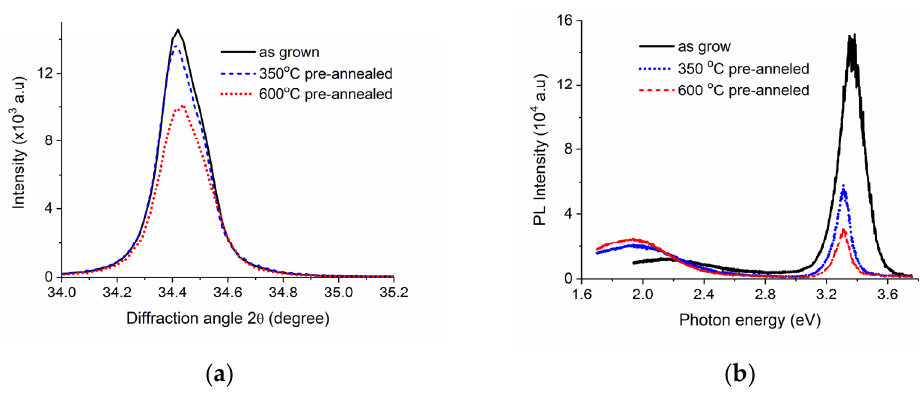
Figure 5. ( a ) XRD spectra ( b ) PL spectra of ZnO nanorods after they are irradiated with H +